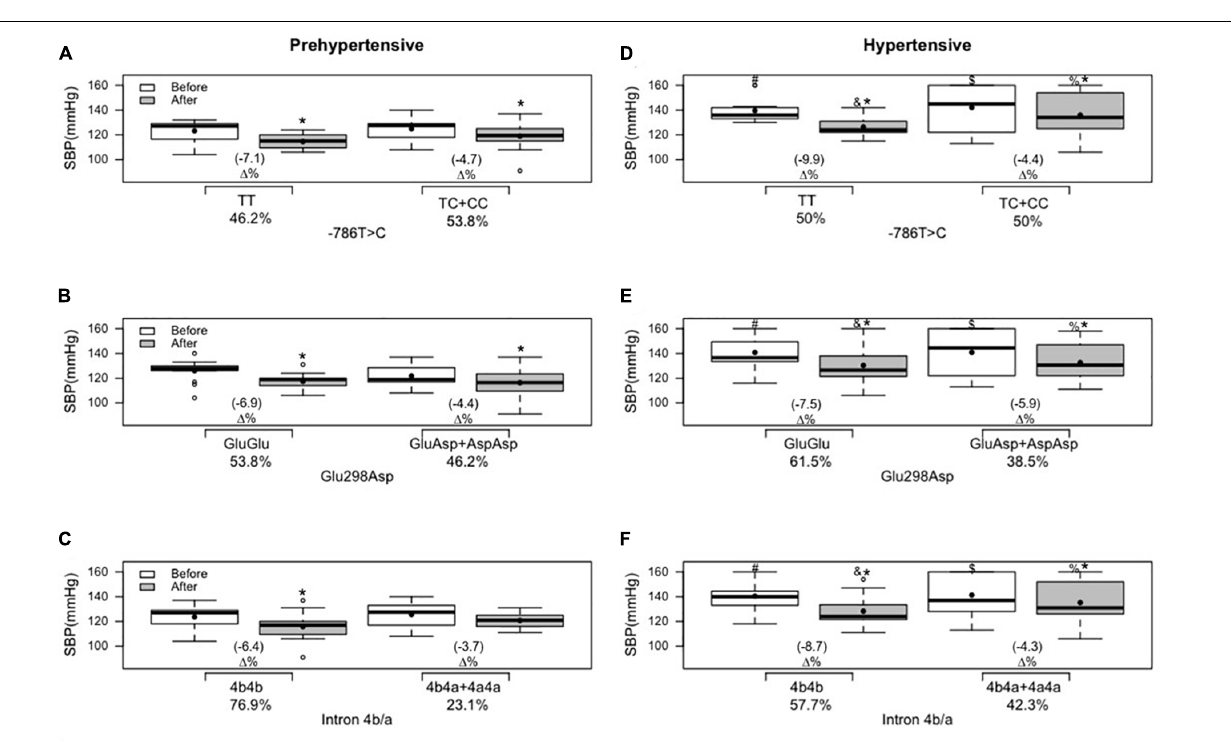
FIGURE 2 | Effects of 12 weeks of multicomponent training on systolic blood pressure (SBP) of 26 prehypertensive and 26 hypertensive older adult women with or without variant genotypes for the NOS3 gene at positions –786T > C, 894G > T (Glu298Asp), and intron 4b/a. * p < 0.05 compared with before the intervention (the same group). # p < 0.05 ancestral genotype of the hypertensive group compared with the ancestral genotype of the prehypertensive group (“TT” versus “TT”; “GluGlu” versus “GluGlu”; “4b4b” versus “4b4b”) before the intervention. $ p < 0.05 variant genotypes of the hypertensive group compared with the variant genotypes of the prehypertensive group (“TC + CC” versus “TC + CC”; “GluAsp + AspAsp” versus “GluAsp + AspAsp”; “4b4a + 4a4a” versus “4b4a + 4a4a”) before the intervention. & p < 0.05 ancestral genotype of the hypertensive group compared with the ancestral genotype of the prehypertensive group (“TT” versus “TT”; “GluGlu” versus “GluGlu”; “4b4b” versus “4b4b”) after the intervention. % p < 0.05 variant genotypes of the hypertensive group compared with the variant genotypes of the prehypertensive group (“TC + CC” versus “TC + CC”; “GluAsp + AspAsp” versus “GluAsp + AspAsp”; “4b4a + 4a4a” versus “4b4a + 4a4a”) after the intervention. (A) Genotypes for the NOS3 gene at position − 786T > C in the prehypertensive group. (B) Genotypes for the NOS3 gene at position 894G > T (Glu298Asp) in the prehypertensive group. (C) genotypes for the NOS3 gene at intron 4b/a in the prehypertensive group. (D) Genotypes for the NOS3 gene at position − 786T > C in the hypertensive group. (E) Genotypes for the NOS3 gene at position 894G > T (Glu298Asp) in the hypertensive group. (F) Genotypes for the NOS3 gene at intron 4b/a in the hypertensive group. Linear mixed-effects